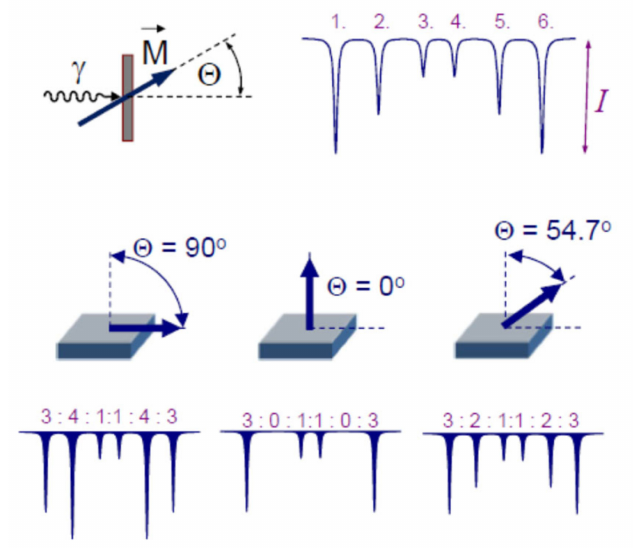
Figure 2. To the explanation of mutual relation between lines intensities of Mössbauer sextet and position of the net magnetic moment of the investigated sample, M , characterized by angle Θ between the sample’s plane and direction of gamma rays, γ , from the Mössbauer